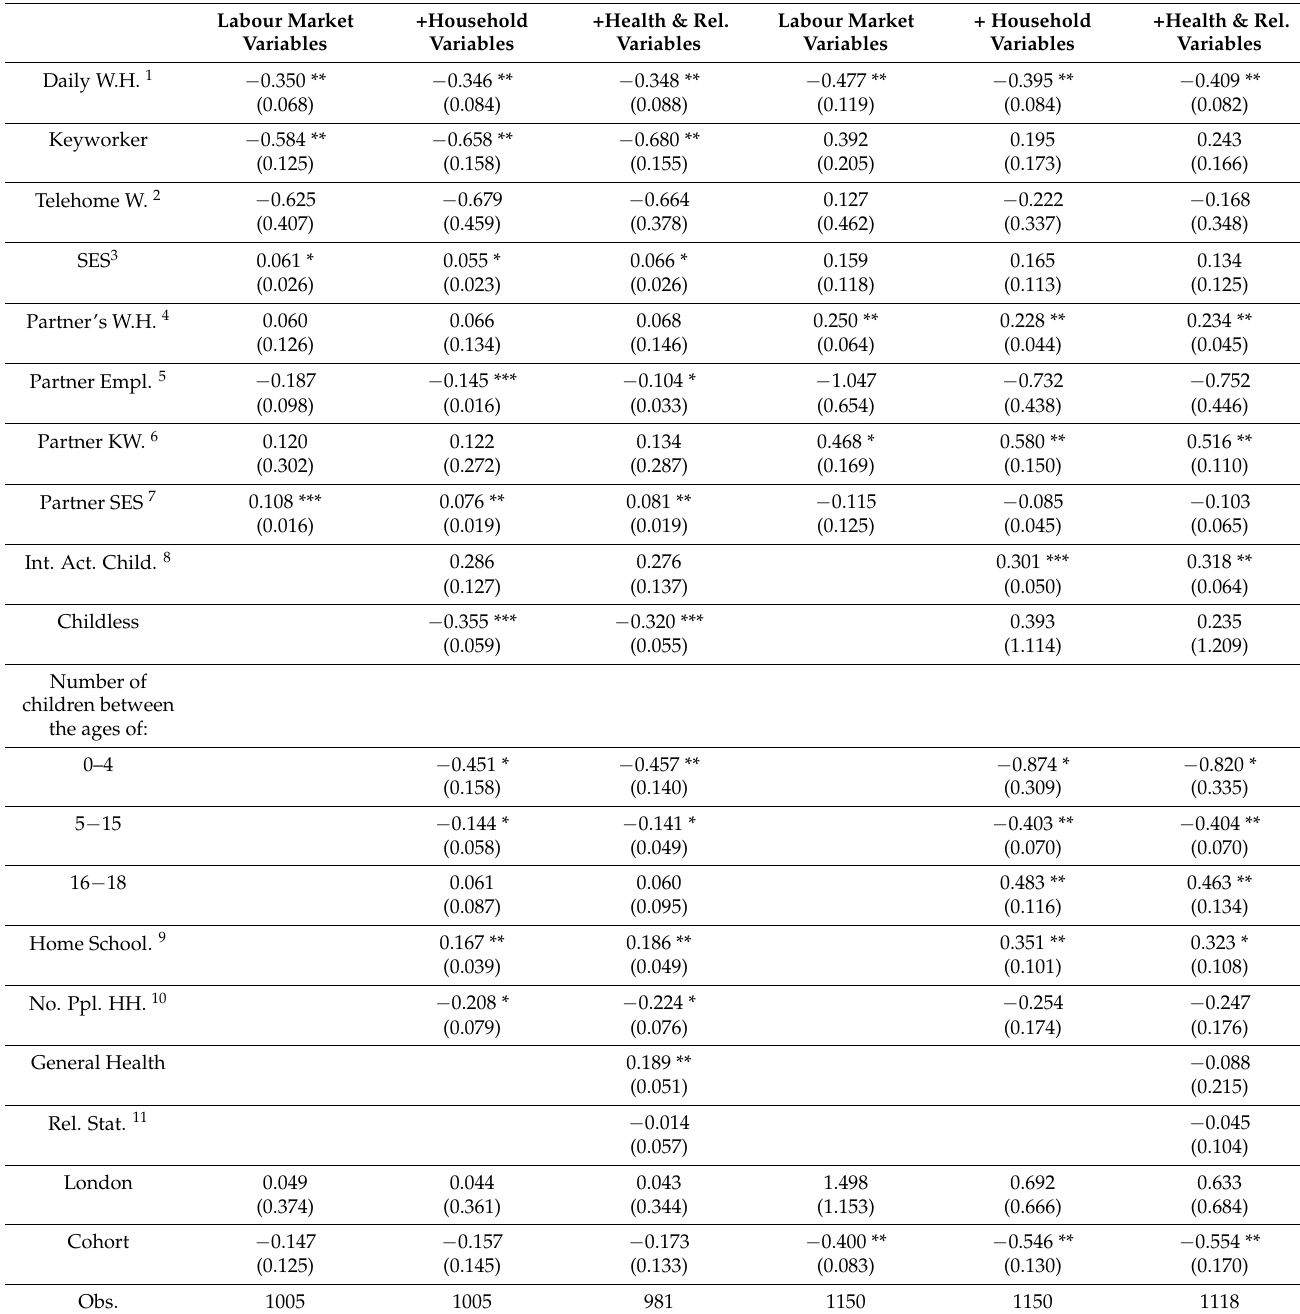
Table 2. Determinants of Daily Time Spent on Housework: OLS Regression Results for Men and Women. Males Males Males Females Females Labour Market +Household +Health & Rel. Labour Market + Household +Health & Rel. Variables Variables Variables Variables Variables Variables Daily W.H.